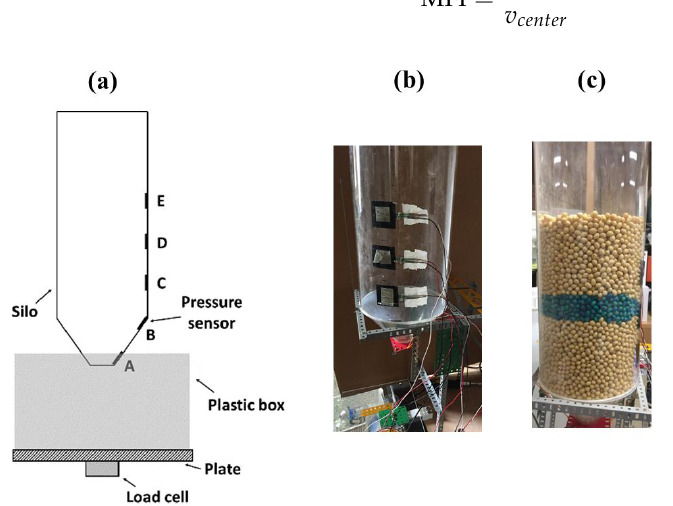
Figure 5. Schematic picture and photo of the experimental setup (( a ) and ( b ), respectively) of the silo for discharge of soybeans, and the soybean-filled silo with the marker soybeans ( c